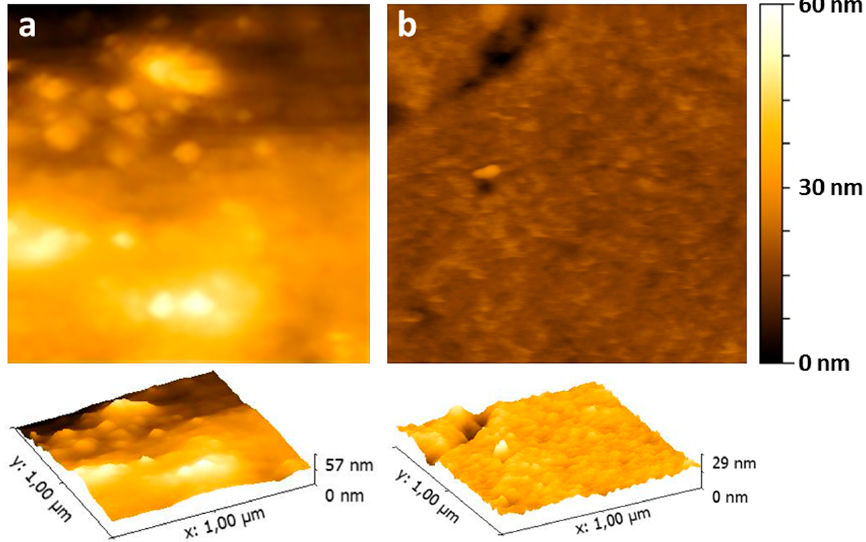
Figure 8. 2D and 3D AFM images of the 1 μ m × 1 μ m area of the Au-3MPS@sPEEK membrane wet for deposition of one drop of water and dried ( a ); and 1 h after drying ( b ), which show the reversibility of the process.